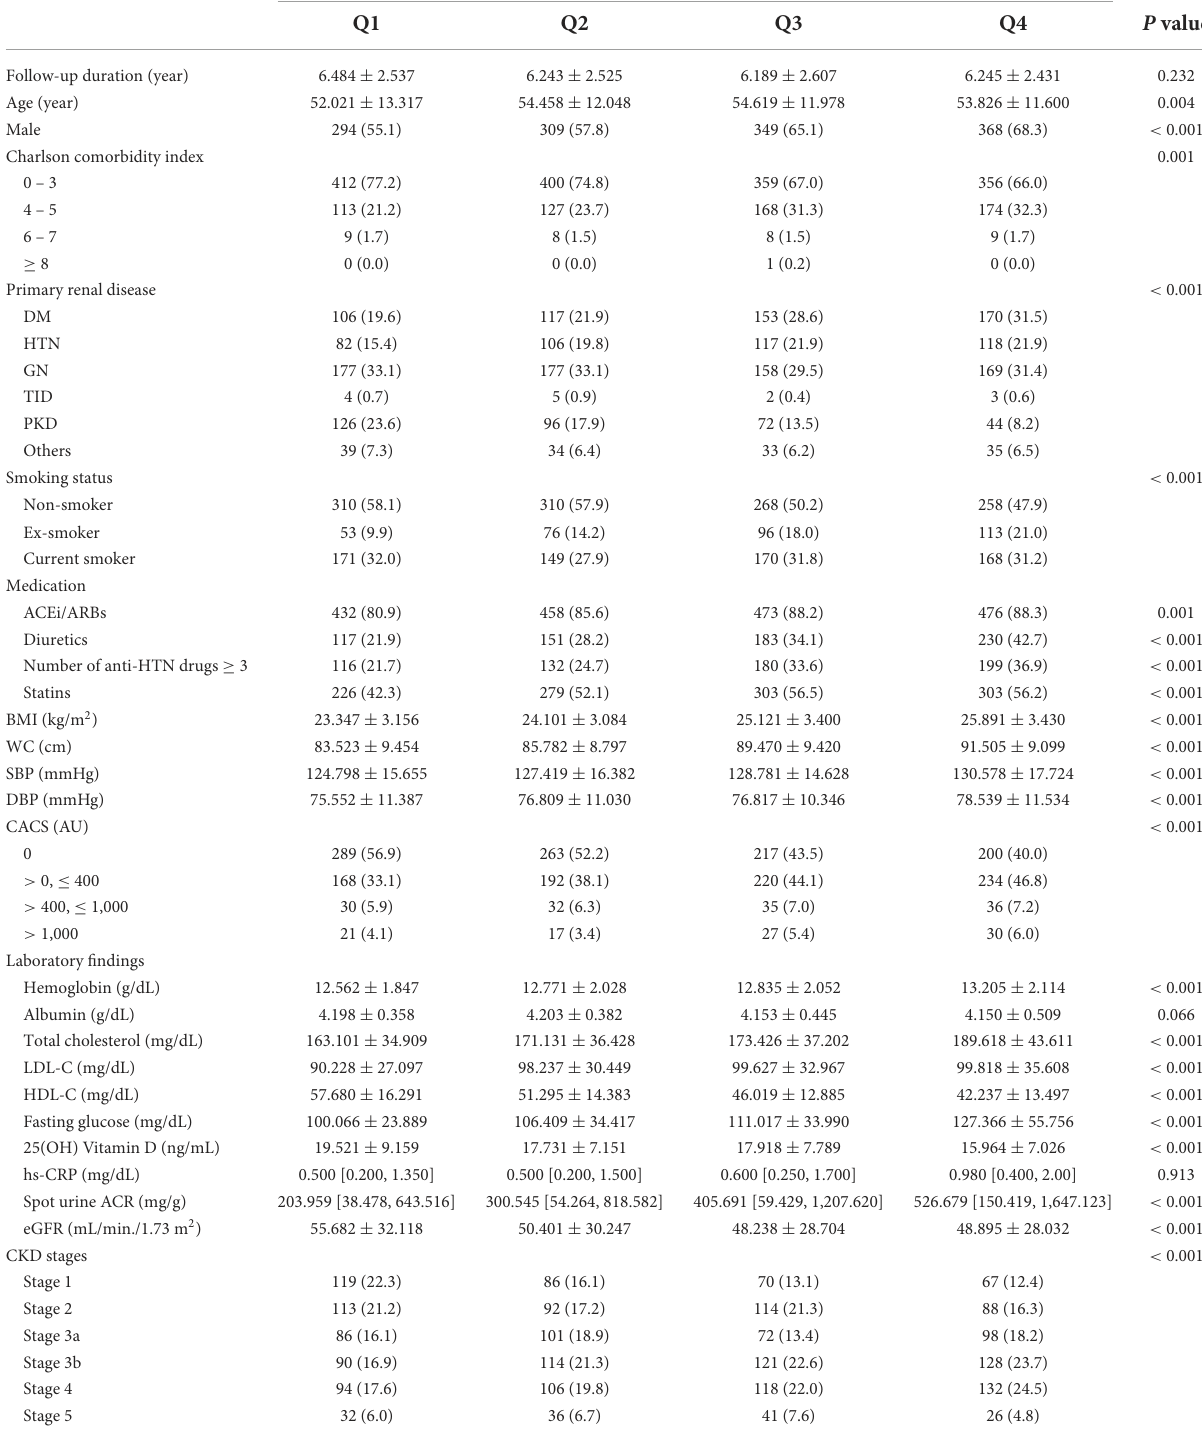
TABLE 1 Baseline characteristics of study participants by serum TG